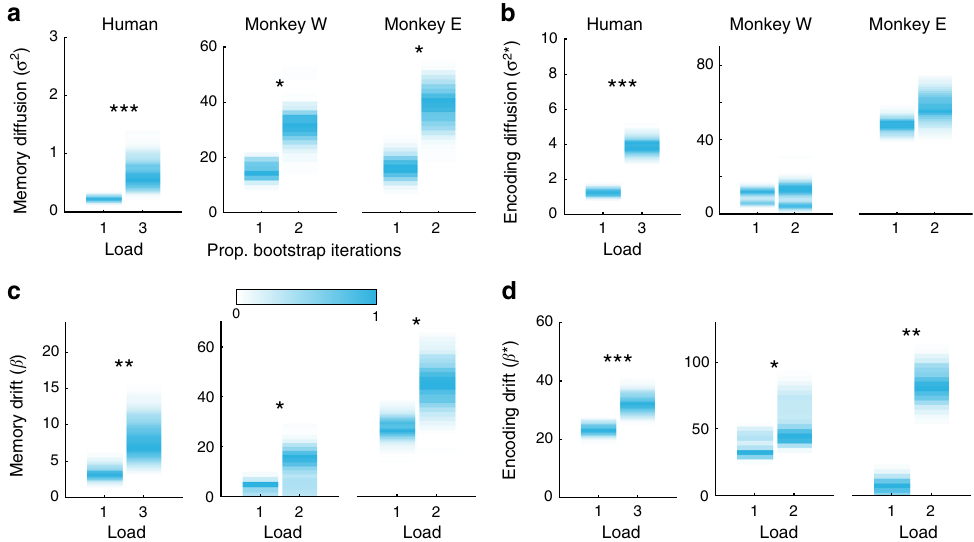
Fig. 6 Drift and diffusion increase with memory load. Experiment 1a maximum likelihood parameter fi ts for the diffusion ( a , b ) and drift ( c , d ) scaling parameters during memory and encoding. Color intensity re fl ects normalized proportion of bootstrap iterations. As detailed in the Methods, all parameters are rates (change per second); dynamics during encoding evolve over a fi xed period of time (simulated as 1 s), while memory dynamics evolve over the memory delay, which varied from trial to trial. * p < 0.05, ** p < 0.01, *** p < 0.001, bootstrap. Source data are provided as a Source Data fi